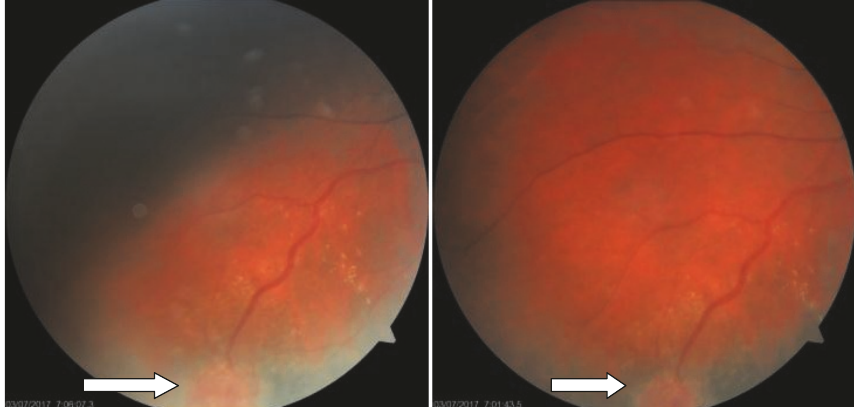
Figure 4: Retinal angioma (white arrow) with a dilated feeding